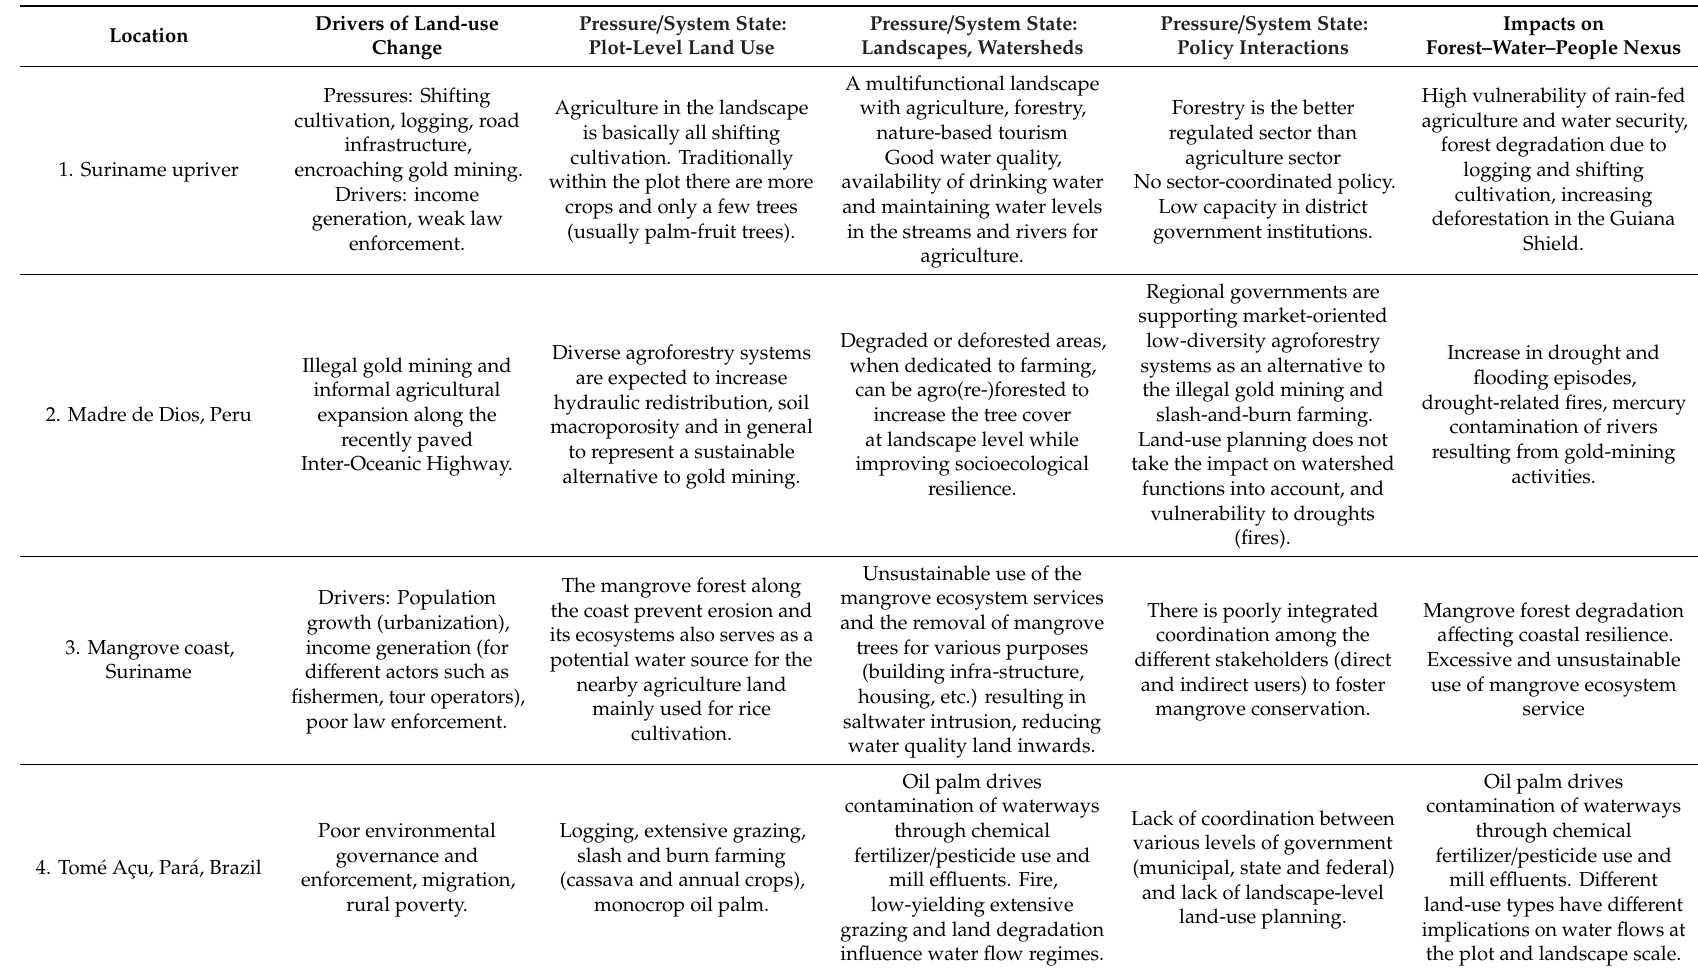
Table 2. Drivers, pressures / system state and impacts across the SESAM landscapes, based on descriptions in Appendix A.